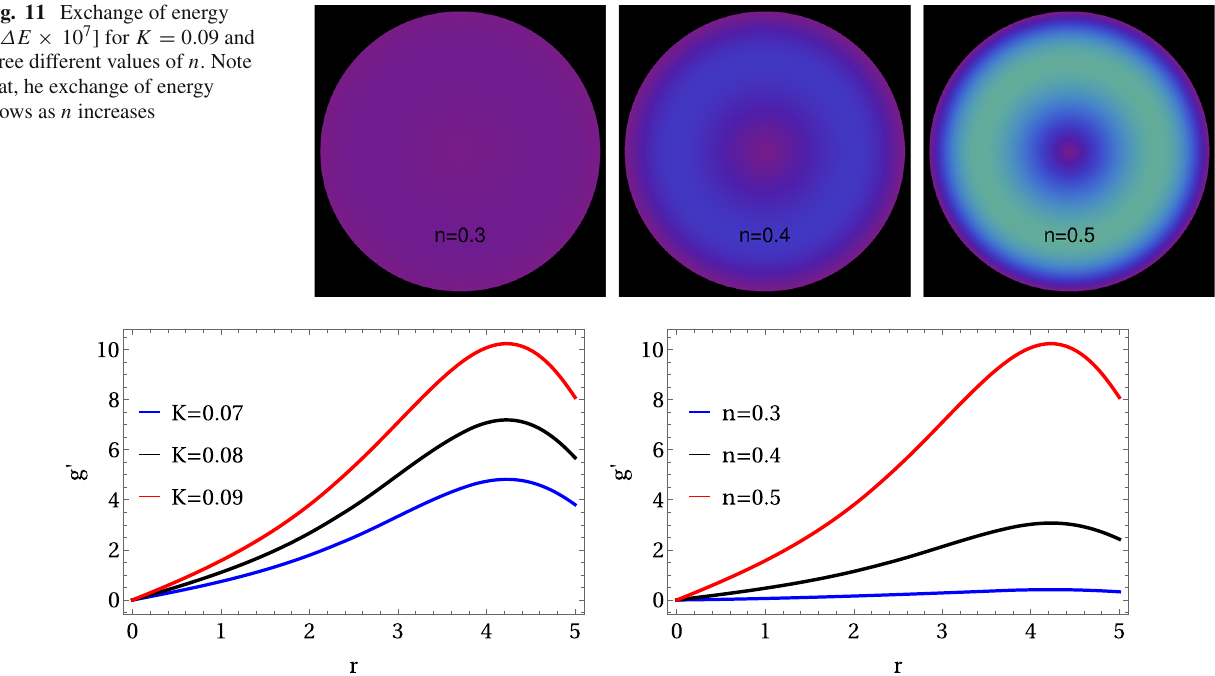
Fig. 12 [ g (cid:4) × 10 4 ] as a function of r for different values of K (left panel, n = 0 . 5) and for different values of n (right pane, K = 0 . 09)